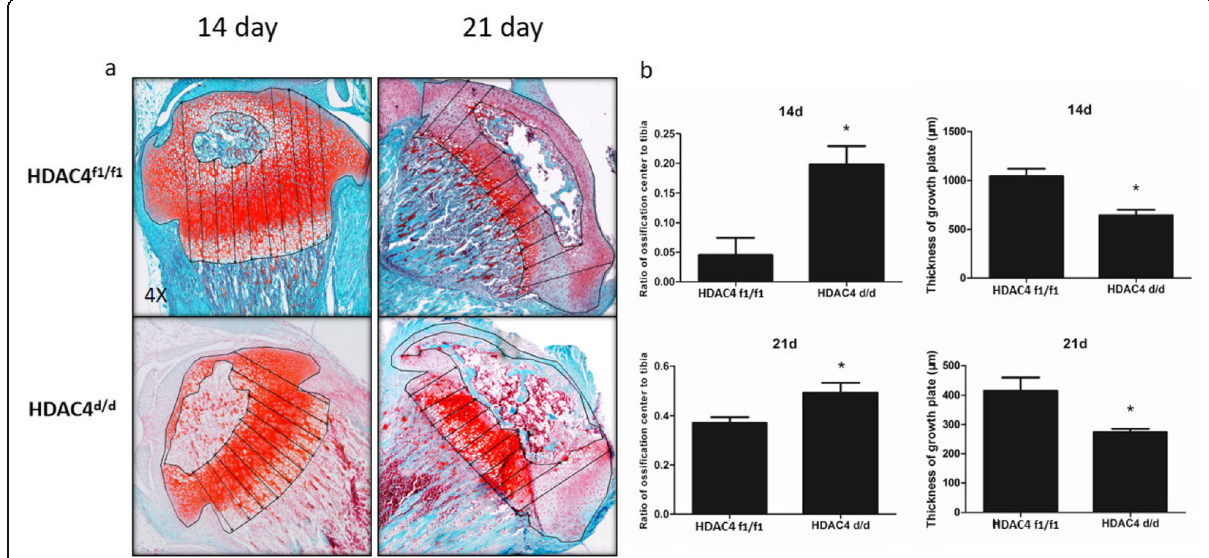
Fig. 2 Shortened growth plates and larger secondary ossification centers in Col2 α 1-Cre; HDAC4 d/d mice. Safranin O/Fast green staining was performed on paraffin sections at days 14 and 21. a Shortened growth plates and larger secondary ossification centers were observed in the Col2 α 1-Cre; HDAC4 d/d mice compared with the HDAC4 f1/f1 mice on postnatal days 14 and 21. b Significant differences in the thicknesses of the growth plates and ratio of area of secondary ossification center to area of tibial plateau were observed between the Col2 α 1-Cre ; HDAC4 d/d and HDAC4 f1/f1 groups on postnatal days 14 and 21. Data are expressed as mean ± SEM. * P < 0.05 vs. the vehicle